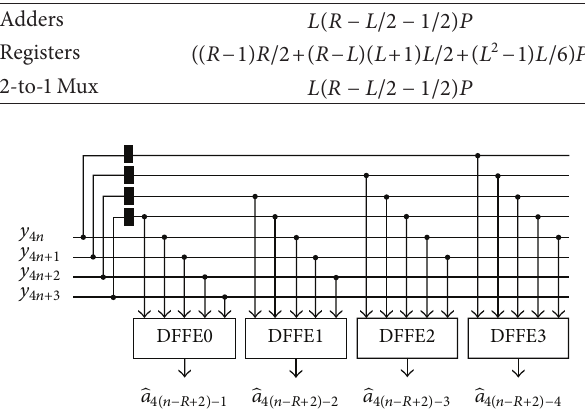
Figure 6: Parallel DFFE architecture for 𝑃 = 4 and 𝐿 = 3 . Blocks DFFEn are as shown in Figure